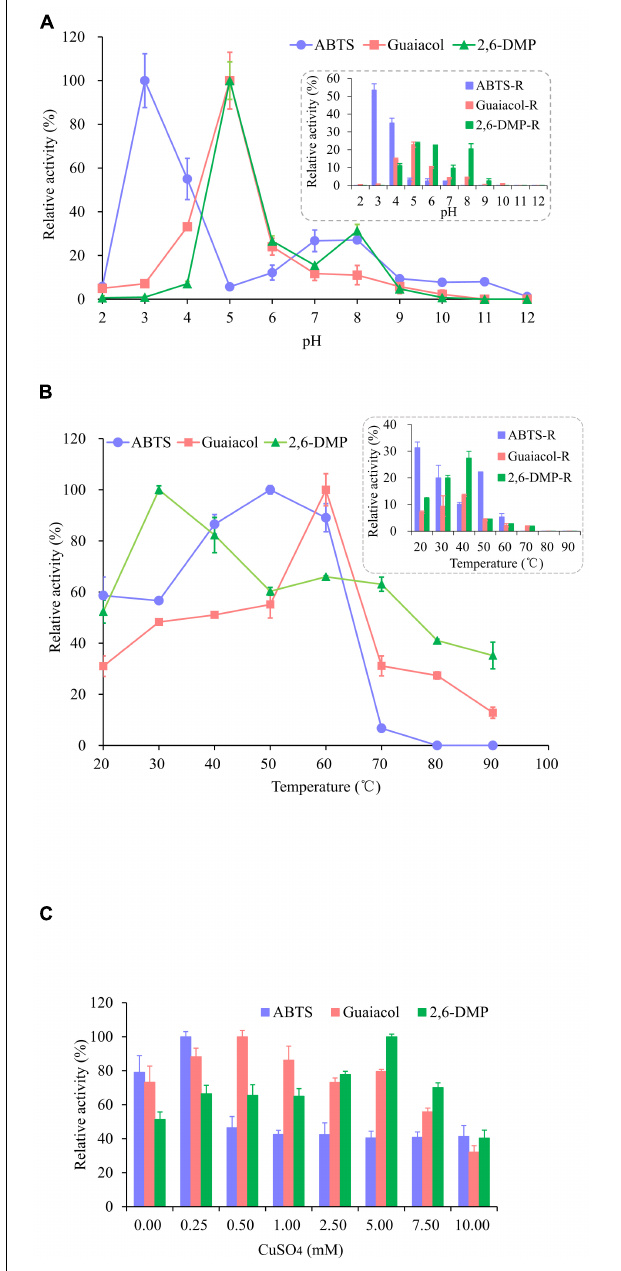
FIGURE 3 | Effects of pH (A) , temperature (B) , and Cu 2 + (C) on the activity and the stability of recombinant OhLac. (A) The relative activity of OhLac at different pH (2.0–12.0) was determined using ABTS, guaiacol, and 2,6-DMP as the substrates. And the residual relative activity (ABTS-R, Guaiacol-R, and 2,6-DMP-R) of OhLac was measured after 1 h at the corresponding pH. (B) The relative activity of OhLac at different temperature (20–90 ◦ C) was determined using ABTS, guaiacol, and 2,6-DMP as the substrates. And the residual activity of OhLac was measured after 1 h at different temperature. (C) The effect of Cu 2 + on relative activity of OhLac adding different concentrations of CuSO4 (0.25, 0.50, 1.00, 2.50, 5.00, 7.50, and 10.00 mM). The relative activity for each substrates was calculated considering the maximum activity as 100% at different pH, temperature and CuSO 4 concentrations, respectively.